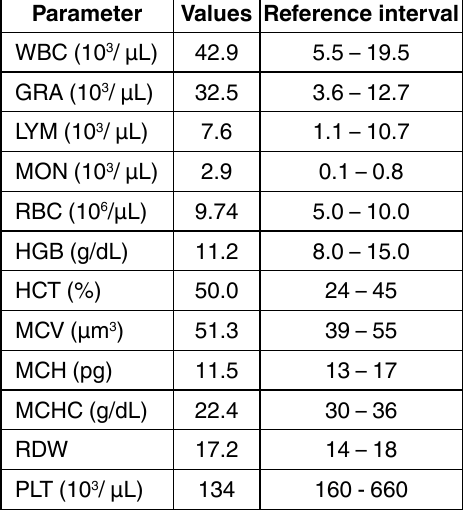
table 1 : Haematology of the kitten with pyothorax on the day of presentation